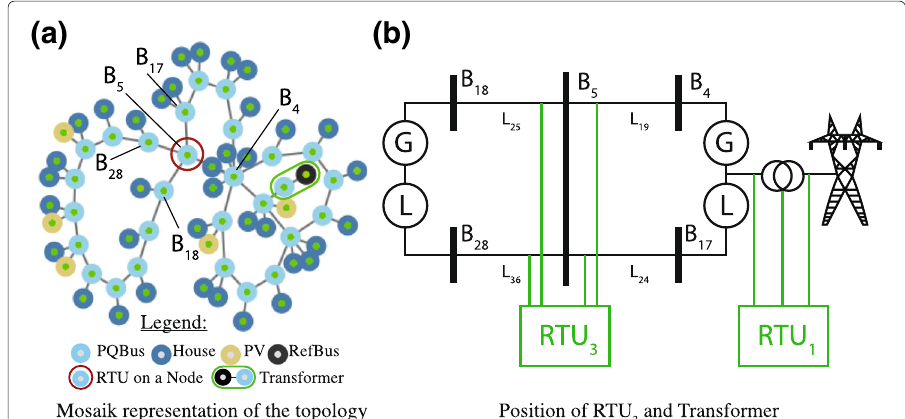
Fig. 4 Power distribution system under analysis in Mosaik notation and simplified as one-line diagram. Figure 4 illustrates the topology simulated in Mosaik for the first Scenario. Figure 4a uses the Mosaik notation, where elements are denoted as dots in different colors and where power lines connecting different elements are denoted with lines. Figure 4b emphasizes the part of the simulated scenario, which is analyzed in this paper. RTU 3 controls bus B_5, which is connected via power lines to four other buses. RTU 1 controls a transformer connecting the High and Medium Voltage